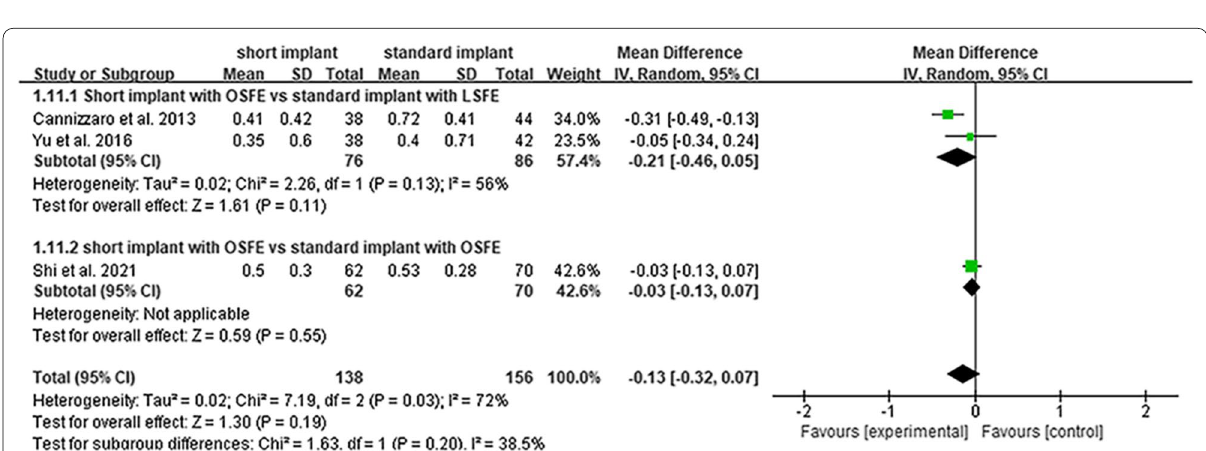
Fig. 6 Subgroup analysis in sinus floor elevation methods of survival rate. The p value of subgroup analysis was higher than the analysis of total studies, showing that the different methods of sinus floor elevation might be a reason for heterogeneity. OSFE osteotome sinus floor elevation, LSFE lateral sinus floor